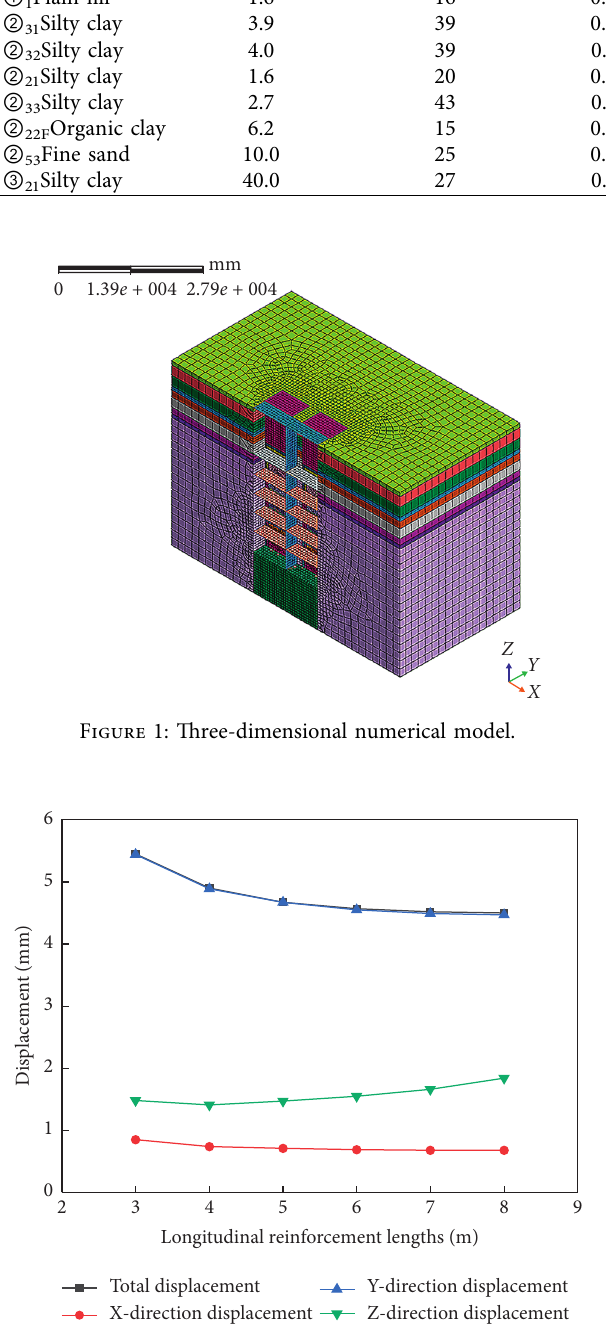
Figure 2: Displacement under longitudinal reinforced lengths of 3m, 4 m, 5m, 6m, 7m, and 8m.